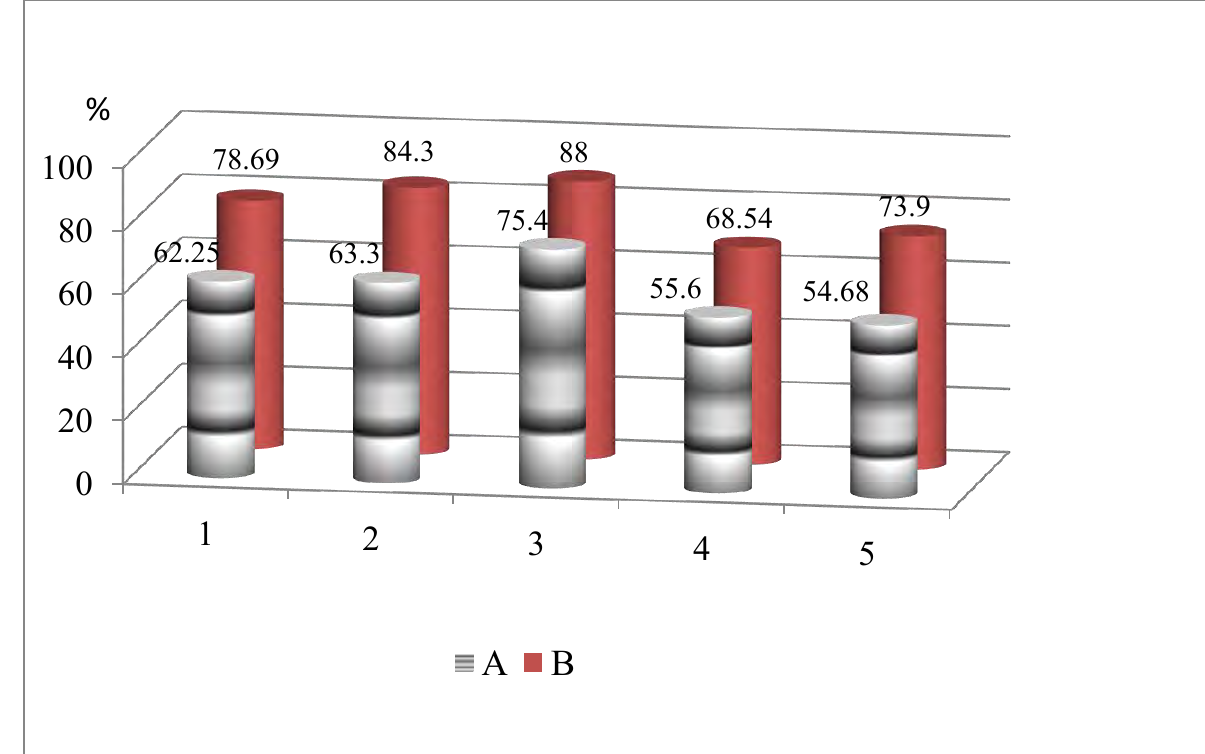
Fig.1. Formation level of acmeological competence and its components in process of continuous professional training of physical education specialists: А – control group of students; В – experimental group of students; 1 – acmeological competence; 2 –acme-motivation; 3 – cognitive component; 4 – activities’ component; 5 – personality’s